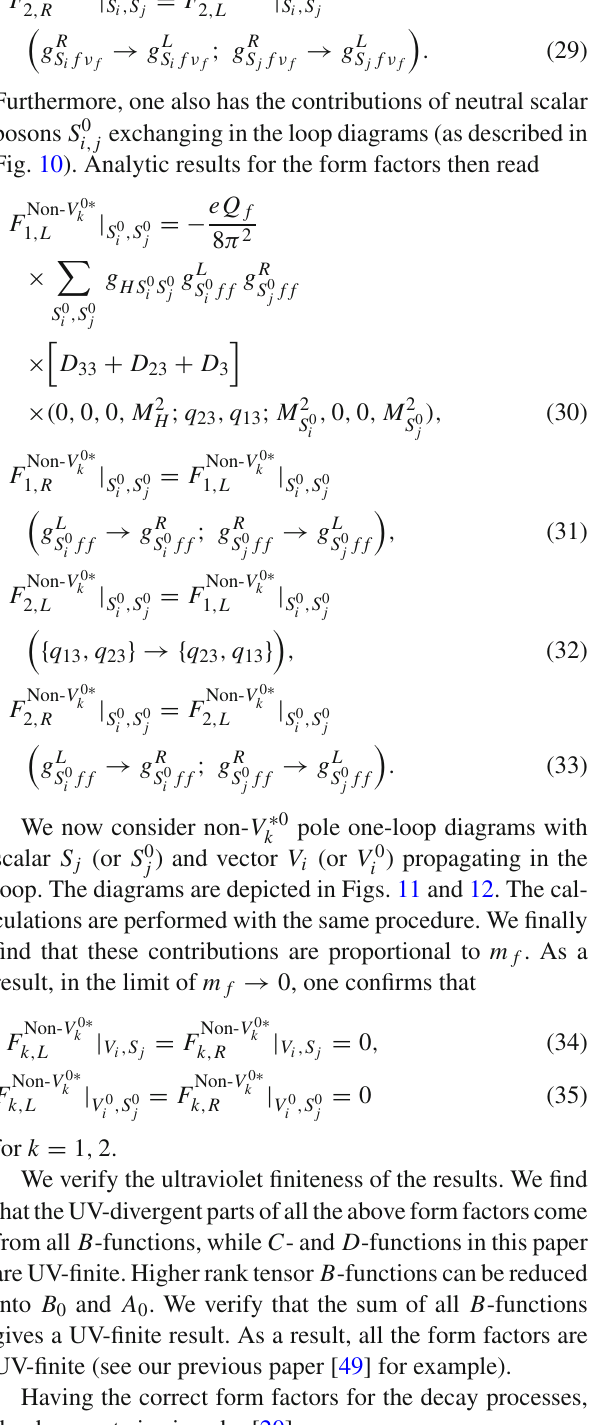
Table 1 All the couplings involving the decay processes H → f ¯ f γ in the SM Vertices